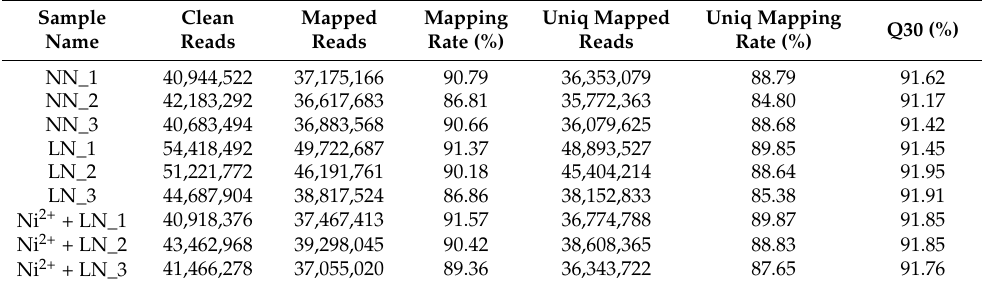
Table 1. Read quality in the RNA-sequencing (RNA-seq) analysis.